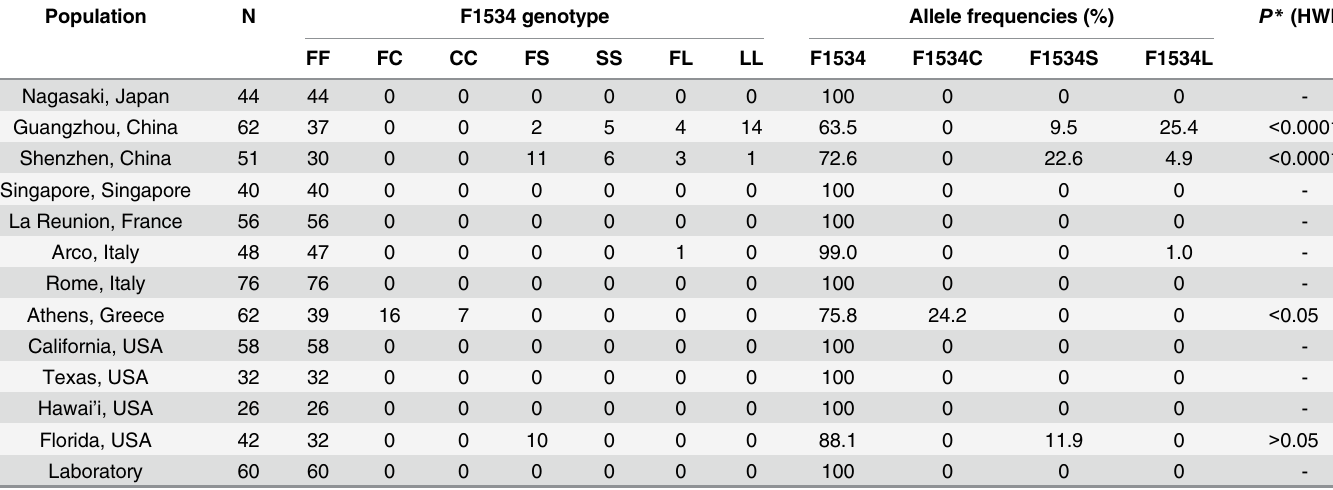
Table 1. Genotyping results of F1534 alleles in the voltage-gated sodium channel gene in 12 Aedes albopictus